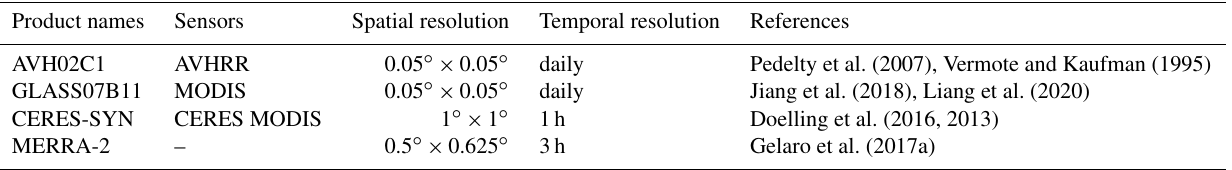
Table 3. List of the satellite and reanalysis products used in this